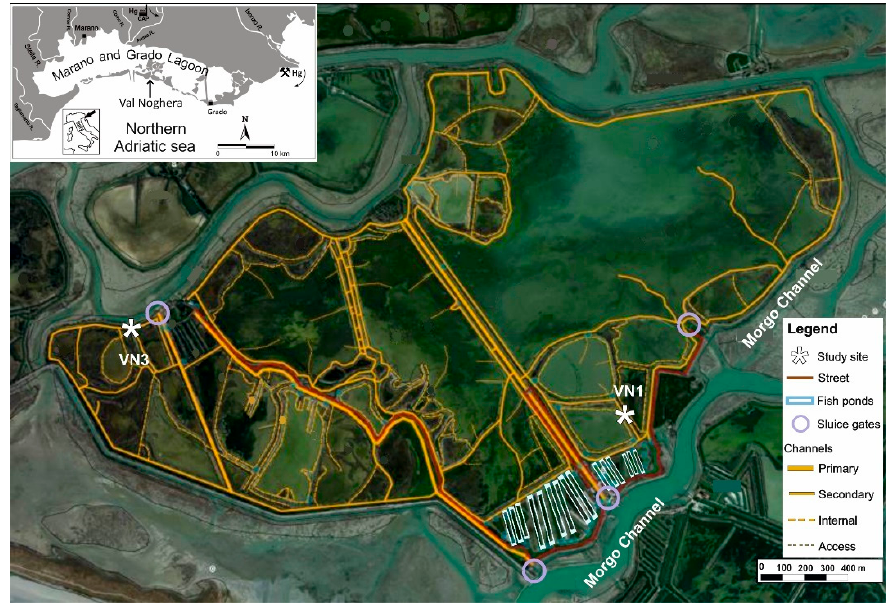
Figure 1. Study area: Val Noghera fish farm with the two sampling sites, VN1 and VN3, located in two of the channels belonging to different sectors of the Marano and Grado coastal lagoon.